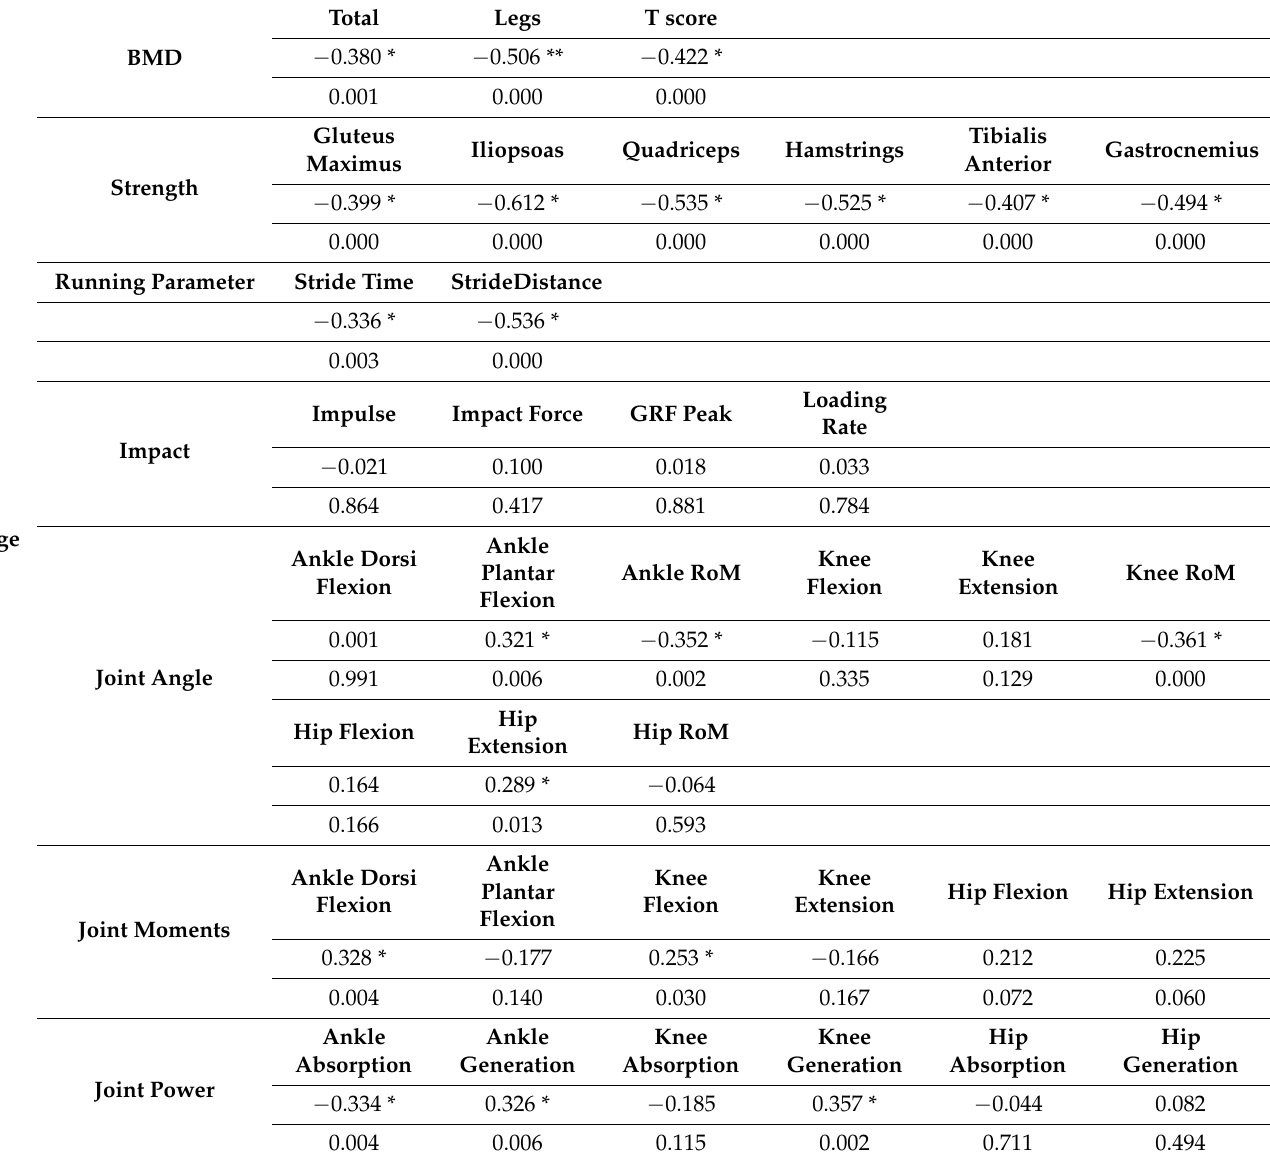
Table 2. Correlations (R, p -value) between age and the variables (i.e., BMD, strength, running parameters, and running